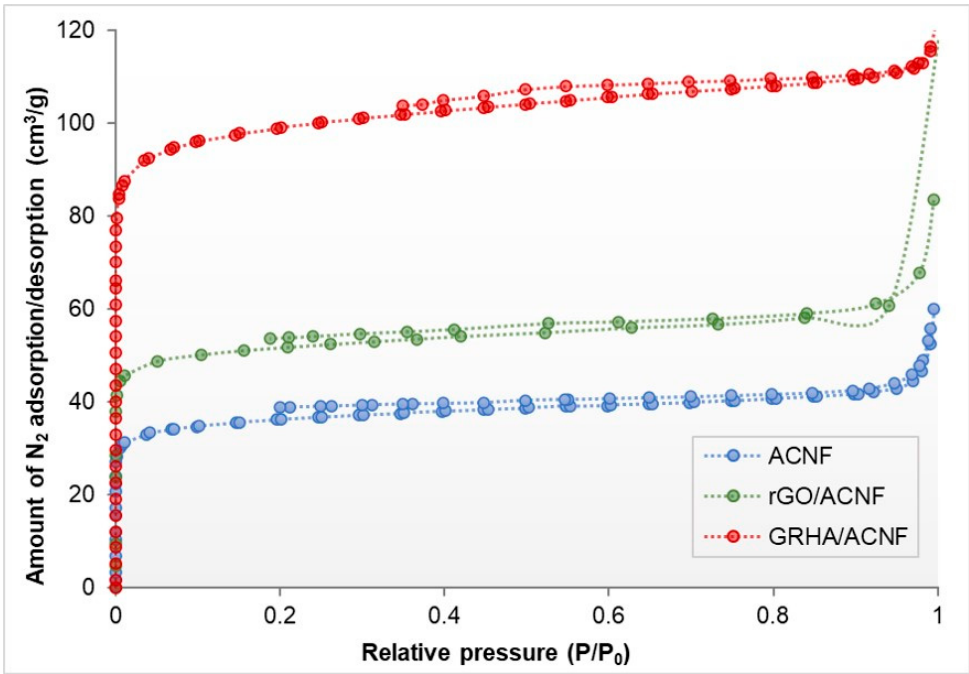
Figure 7. Nitrogen adsorption/desorption of pristine ACNF, rGO/ACNFs, and GRHA/ACNF at − 196 °C and 1 bar. ACNF: activated carbon nanofibers, rGO: ACNF: activated carbon nanofibers, GRHA: graphene-derived rice husk ashes.